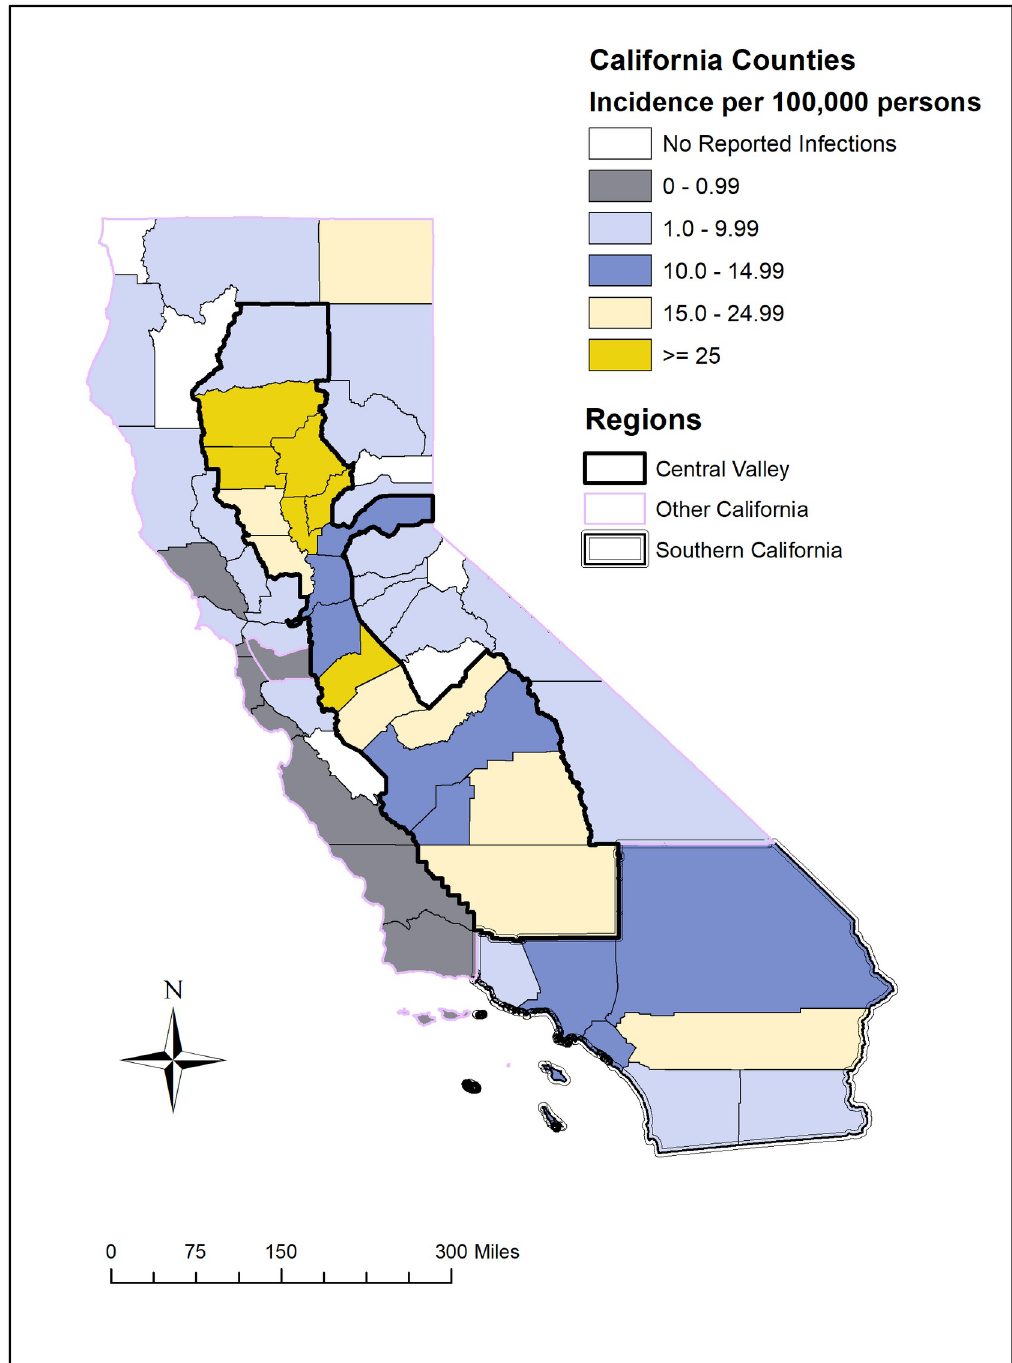
Fig 2. West Nile neuroinvasive disease cumulative incidence per 100,000 persons, by county, California, 2003–2018. other California (45.2, 19.1, and 4.0 infections / 100,000 persons, respectively) (Fig 2). Sparsely populated Glenn County, situated within the rice growing region of the northern Central Val- ley, had the highest cumulative incidence of WNND and total disease incidence (neuroinvasive